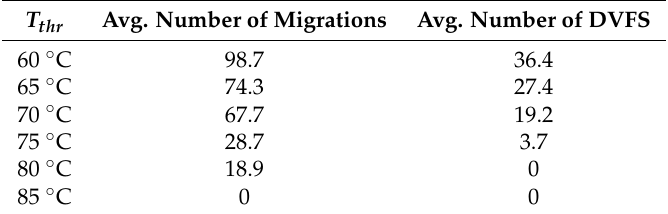
Figure 8. Normalized memory accesses with and without clustering at 60 ◦ C threshold temperature. Table 5. The average number of times task migration and DVFS have been used in DTaPO at different thermal